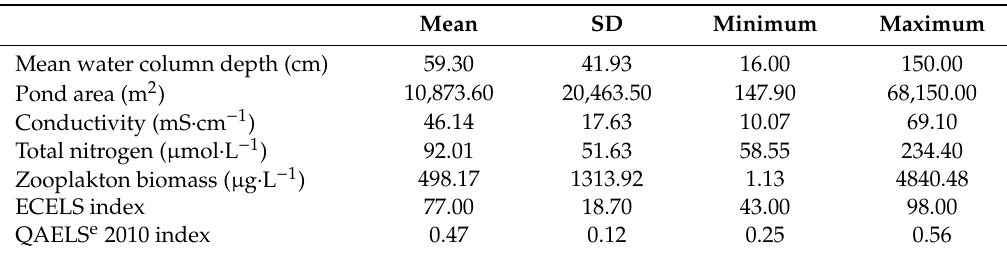
Table 1. Mean, standard deviation (SD), minimum and maximum values of the abiotic and biotic factors and ecological status indexes measured in the study ponds (N = 10). ECELS: Conservation Status of Lentic and Shallow Ecosystems and QAELS: Water Quality of Lentic and Shallow Ecosystems.